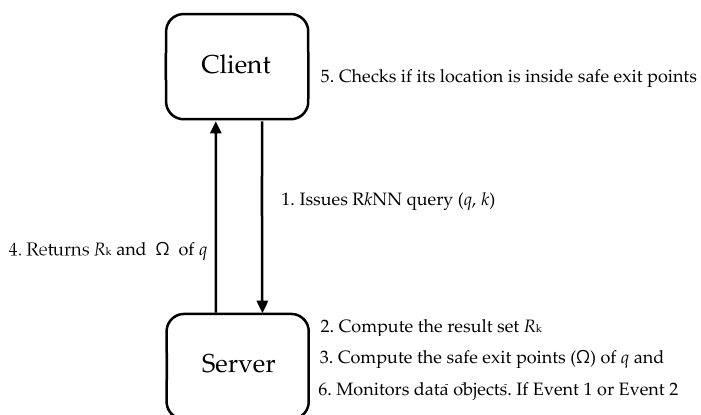
Figure 2. Request flow for processing R k NN queries.